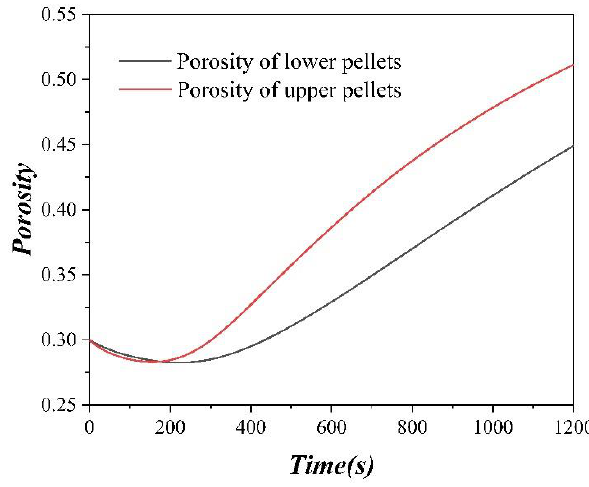
Figure 11. Variation in the pellet Figure 11 . Variation in the pellet bed.